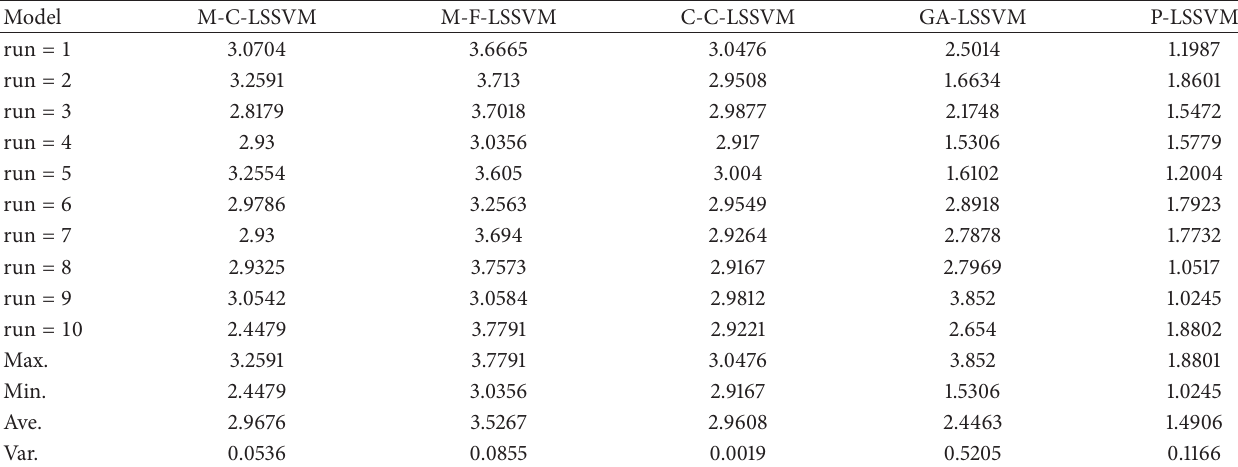
Table 13: Five models predicted error based on NMSE for interphone band.